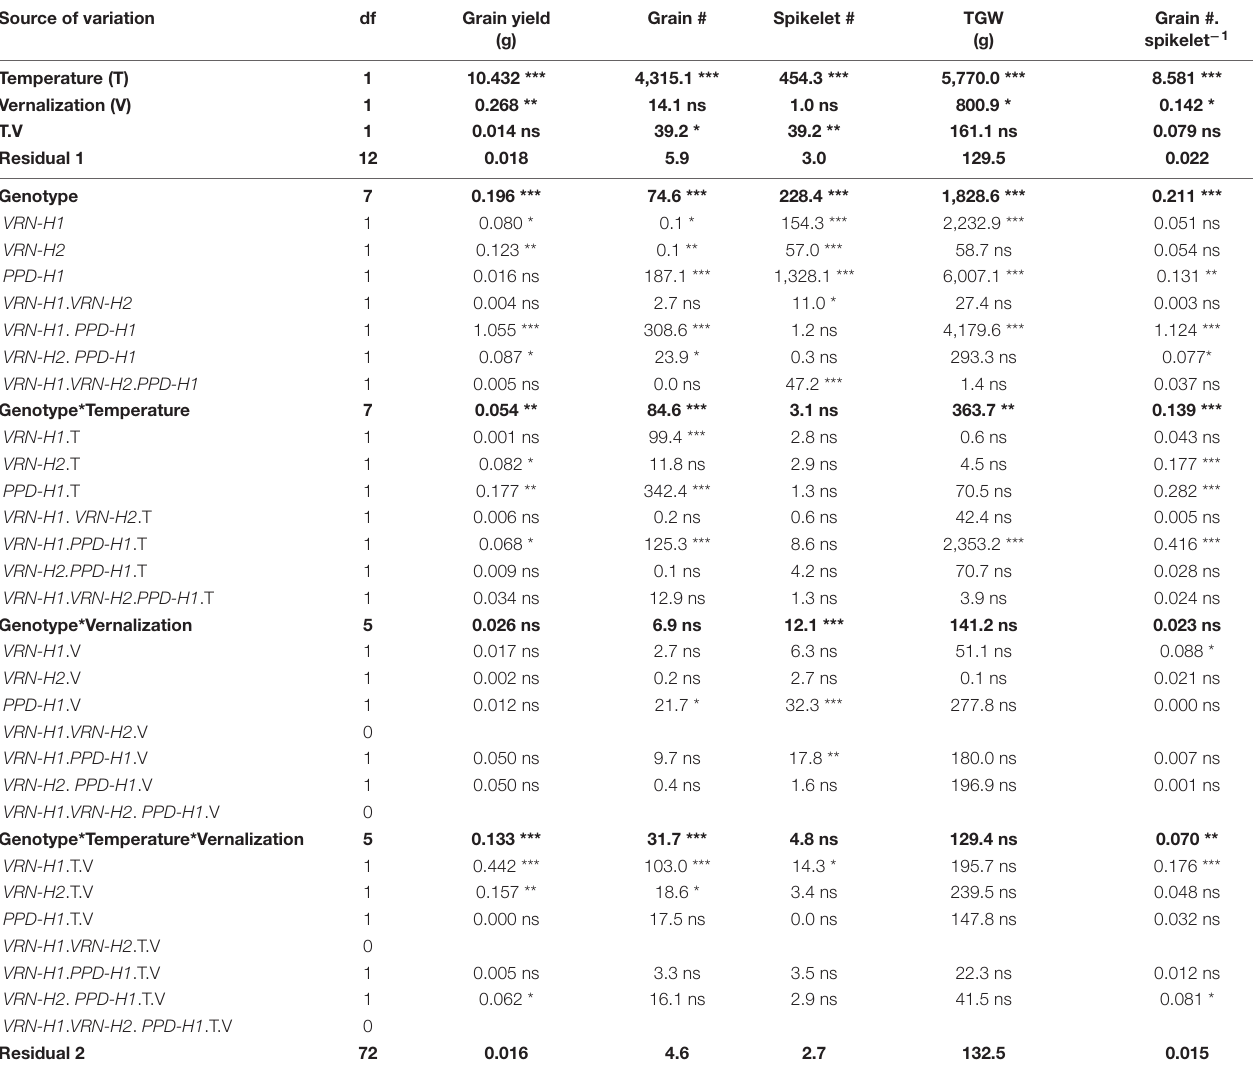
TABLE 3 | Mean squares from the analyses of variance for inflorescence traits measured at the main spike of each plant, corresponding to the eight NILs. Source of variation df Grain yield